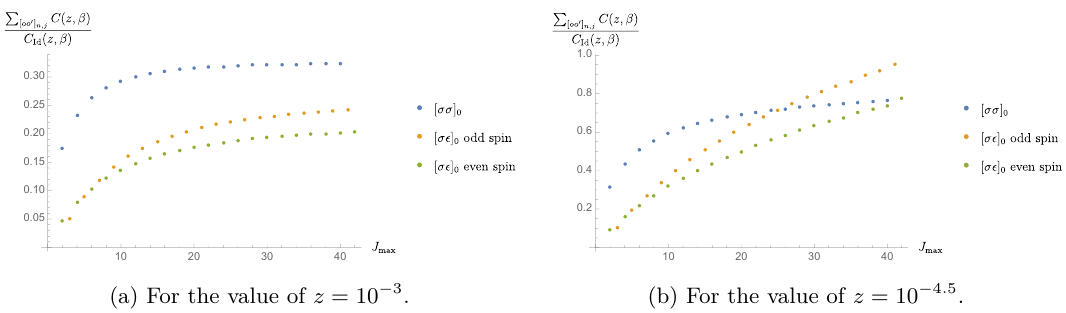
Figure 14 . Partial sum over the contributions of different families for the spin 2 operator with β = 6 . 18